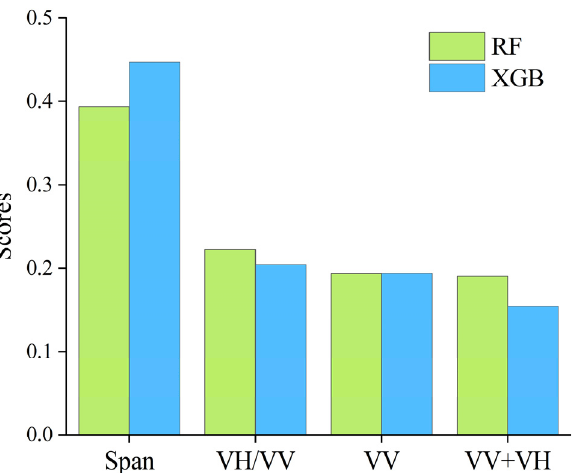
Figure 11. Statistical results of feature importance scores (Span, VH/VV, VV, VV+VH).